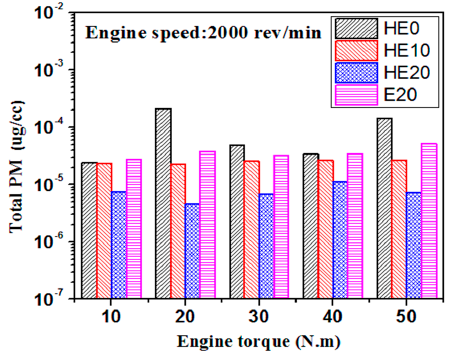
Figure 7. Difference of total particle mass with engine load.